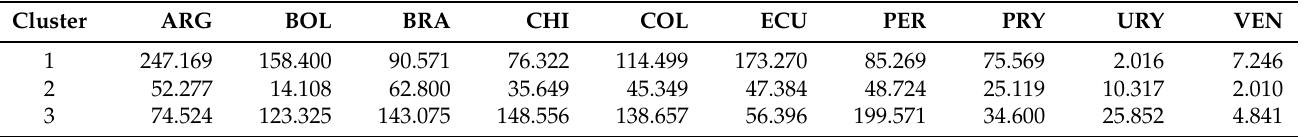
Table 11. Center of the listed cluster for the number of COVID-19 deaths in the indicated country using the k-means method. Cluster ARG BOL BRA CHI COL ECU PER PRY URY VEN